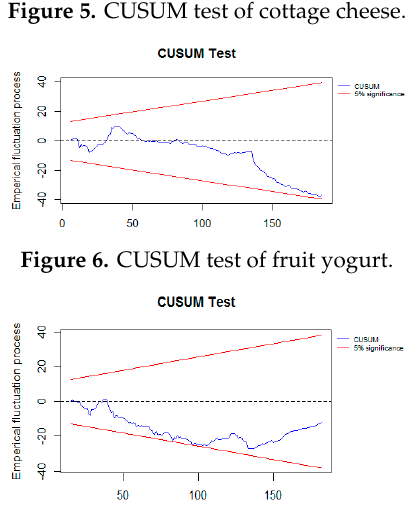
Figure 5. CUSUM test of cottage cheese. Figure 4. CUSUM test of butter cream.